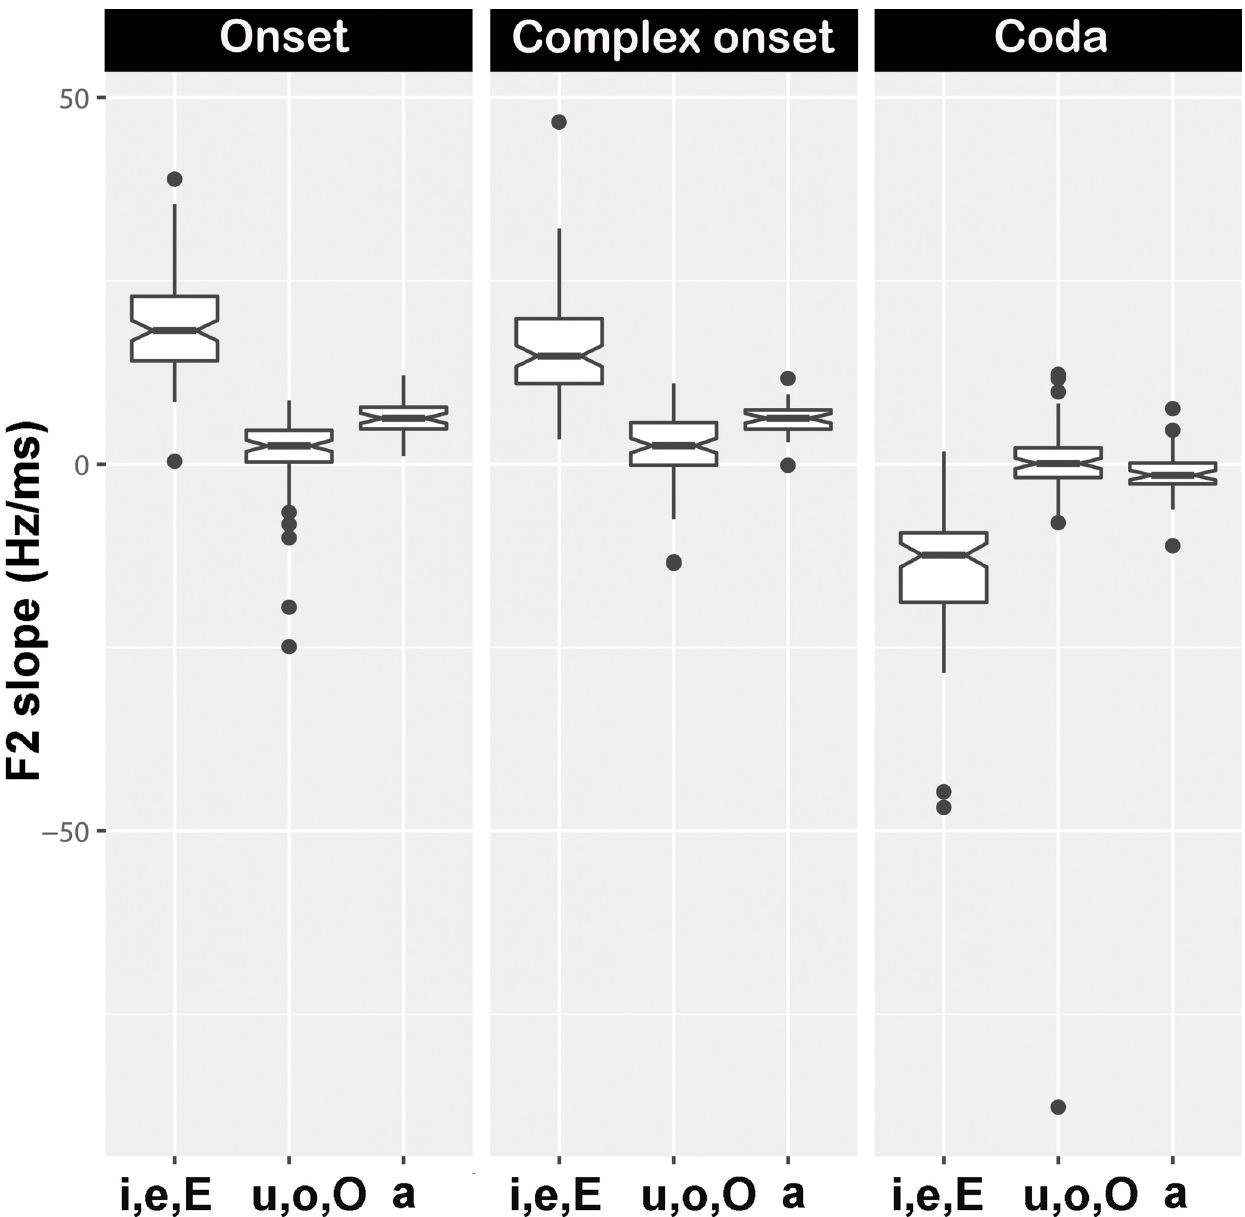
Fig 2. Slope of F 2 transition for [i, e, ε ], [u, o, ɔ ] and [a] contexts in all syllable positions. /l/ in all word-positions and vowel contexts [1,3,8,31]. However, the explanation for /l/ velari- sation as a continuum solely based on F values breaks down here, since /l/ produced in vari- 2 ous syllable positions and vowel contexts were not statistically different and there was no interaction between vowel context and syllable position. For EP, the absence of significant dif- ferences between onset and coda position had already been reported for F [3,8], although 2 slightly higher absolute values for coda position had been observed. Nevertheless, Oliveira et al. [54] reported significant higher F values for /l/ in intervocalic position than for /l/ in 2